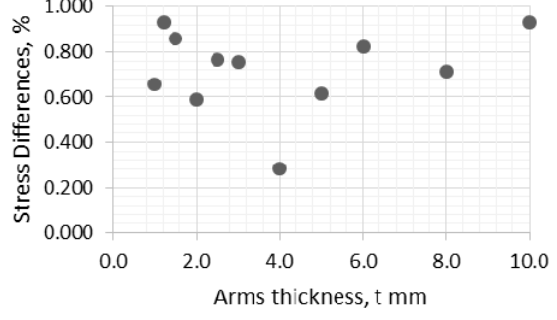
Figure 6: Center stress differences. Figure 7: Stress distribution in the optimized geometry, t=5mm, Load Case 1.